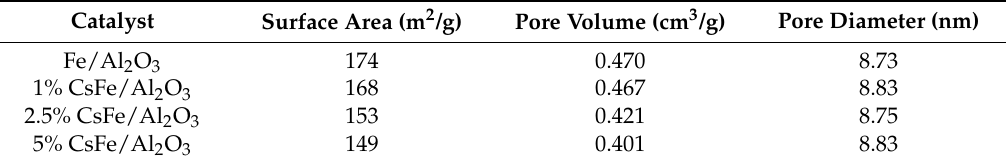
Table 1. Textural Properties of the prepared catalysts.